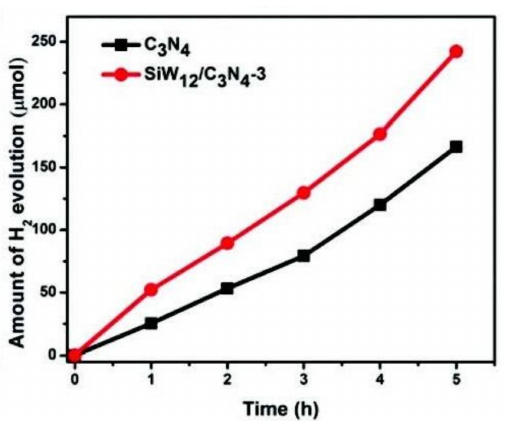
Figure 6. Comparison of the hydrogen generation rate of the hybrid SiW 12 /C 3 N 4 -3 with g-C 3 N 4 under visible light irradiation